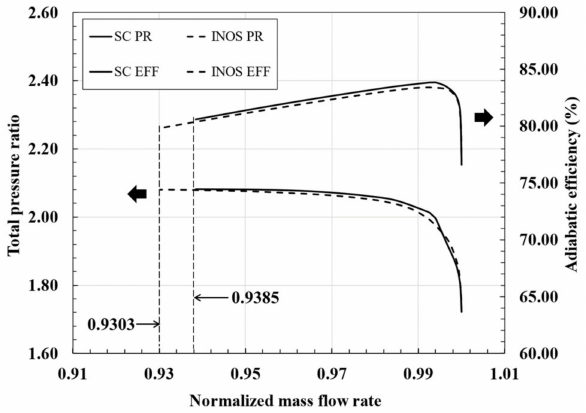
Figure 5. Performance curves for smooth casing and reference